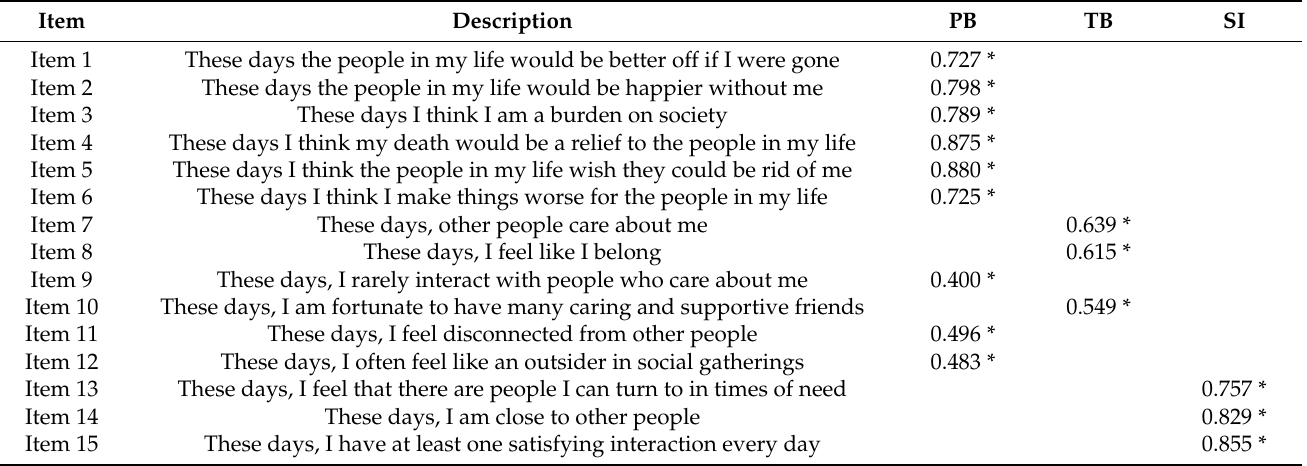
Table 3. Oblique rotated loadings for three-factor model for Sample 1 ( n =